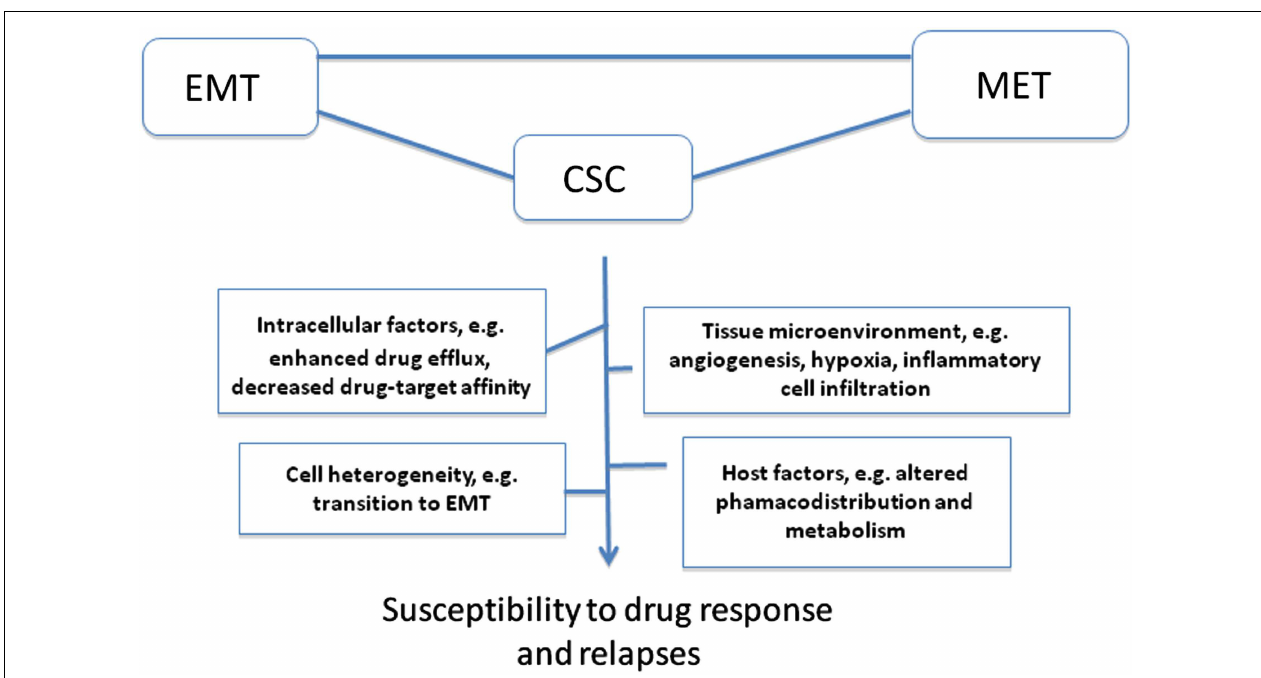
force for drug resistance.Tumors can develop resistance via regulation of their microenvironment, e.g., by remodeling the extracellular matrix, deregulating cancer cell-endothelial cell/immune infiltrating cell interactions, leading to enhanced angiogenesis, hypoxia, and resistance to cell death. In this context, epithelial-mesenchymal transition (EMT) and the reverse process mesenchymal-epithelial transition (MET), both are critical process for cancer progression to metastasis and homing in distant site contribute to drug resistance via various mechanisms, including induction of cell heterogeneity and selection of rare cancer stem cell (CSC) variants with intrinsic resistance to